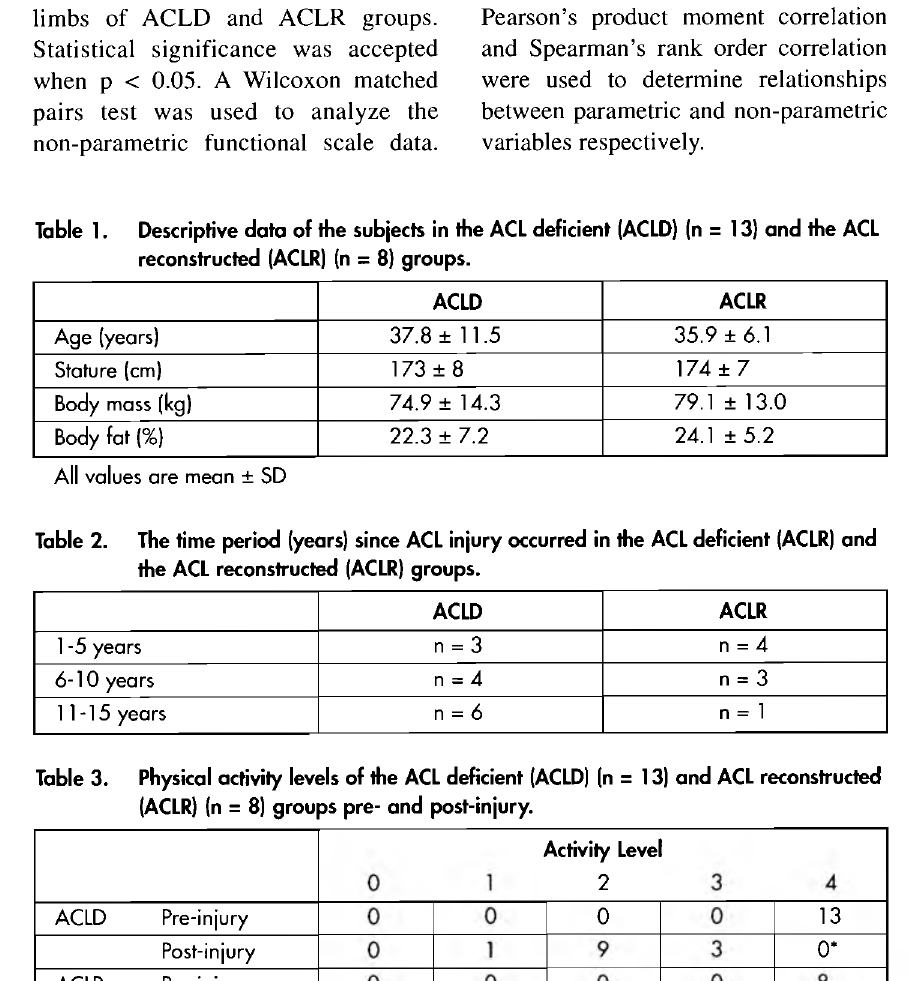
Physical activity levels of the ACL deficient (ACLD) (n = 13) and ACL reconstructed (ACLR) (n = 8) groups pre- and post-injury.